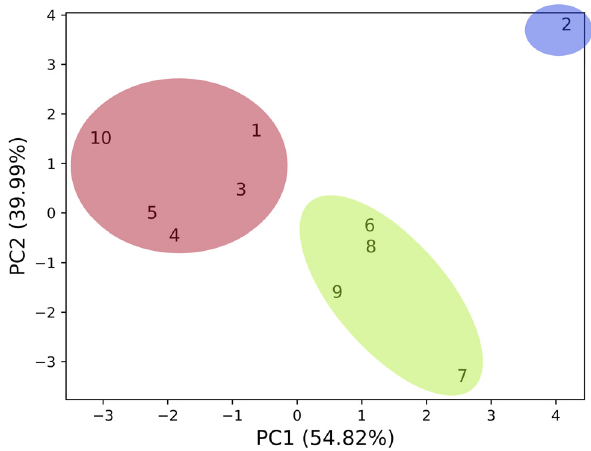
Figure 10: PCA score plots of chlorogenic acid, echinacoside, and isorhamnetin - rutinoside in ten